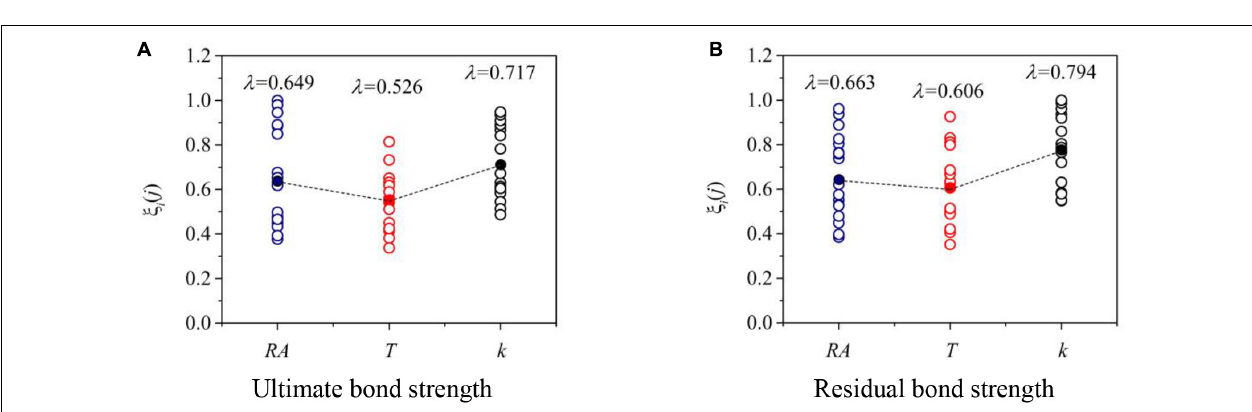
FIGURE 10 | Results of gray relational coefficient and degree. (A) Ultimate bond strength. (B) Residual bond strength.